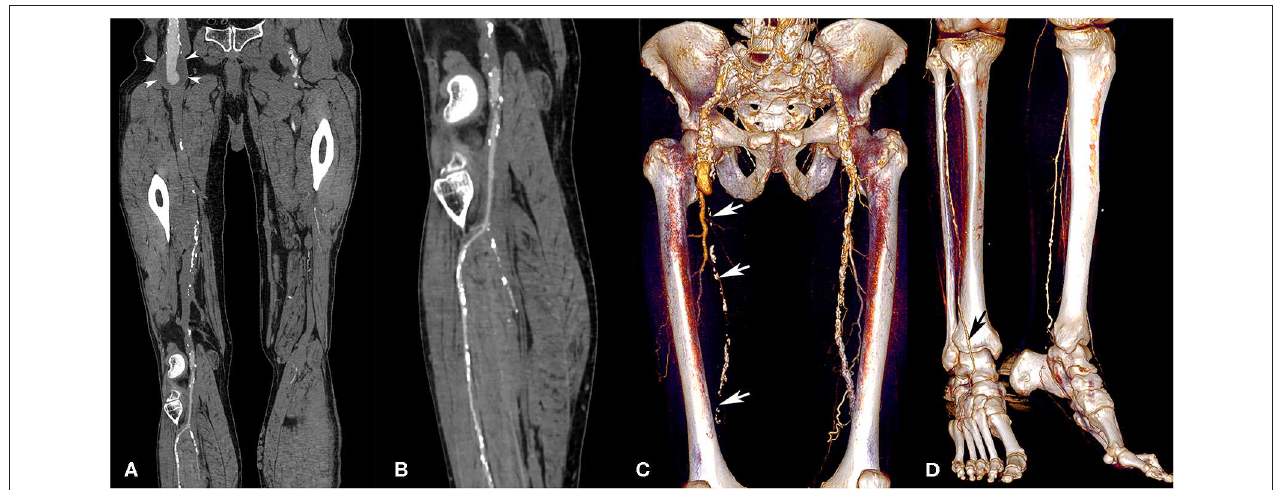
FIGURE 4 | Lower extremity CT angiography obtained with the AA technique in a 75-year-old man with a history of bilateral chronic limb ischemia who had increasing pain on exertion for about a week. Curvilinear reconstructions of the right iliofemoral arterial axis (A) and anterior tibial artery (B) show optimal image quality despite the presence of an aneurysm of the abdominal aorta and right external iliac artery (arrowheads). Volume rendering reconstructions show a long-segment occlusion of the right superficial femoral artery (white arrows, C ), yet an optimally enhanced anterior tibial artery ( D , black arrow). Attenuation measurements were as follows: aortic level, 235 HU; iliac level, 222 HU (right) and 231 HU (left); femoral level, 188 HU (right), and 233 HU (left); tibial level 235 HU (right), and 218 HU (left); pedal level, 168 HU (right), and 130 (left). HU, Hounsfield units.